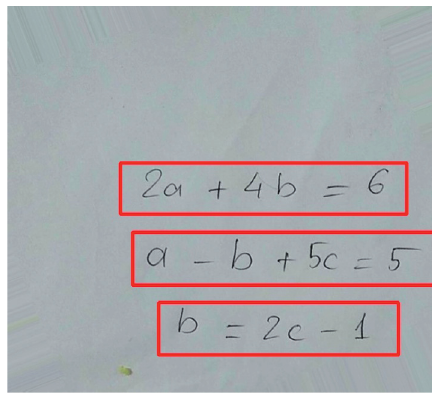
Figure 13: Image after rotating and identifying.